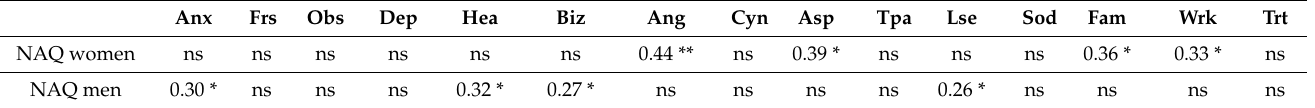
Table 8. Gender differences in correlations between the NAQ and MMPI-2 content